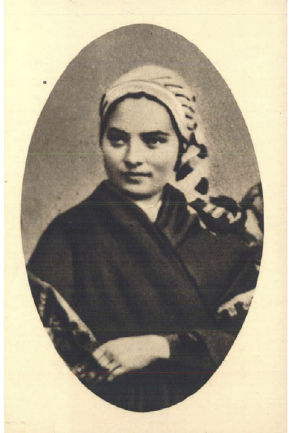
Fig. 3 J.-B. C., Lourdes